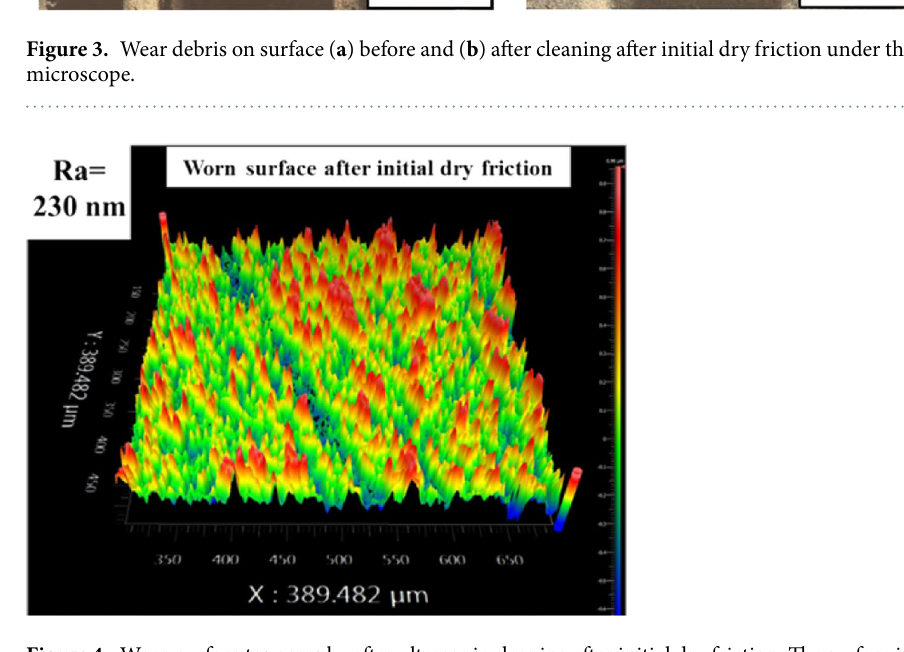
Figure 4. Worn surface topography after ultrasonic cleaning after initial dry friction: The surface is more coarse, and the peak of asperities obviously increases; the surface roughness is 230